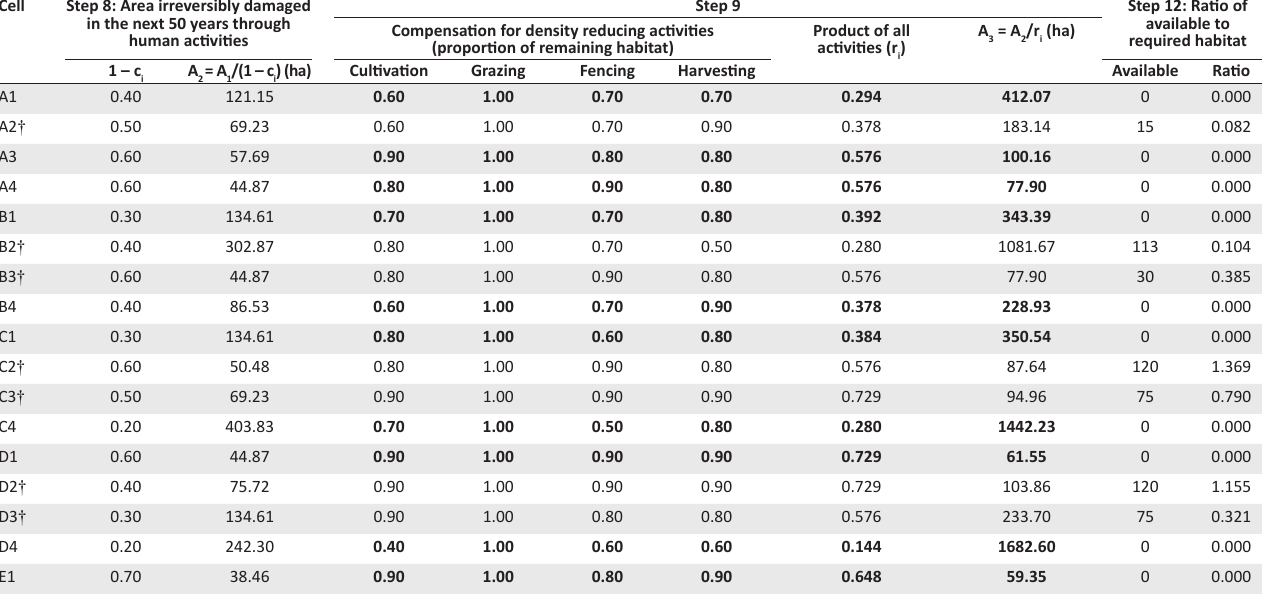
TABLE 2c: Brackenridgea zanguebarica minimum conservation area size using Burgman et al. ’s method (Steps 8, 9 and 12): Scenario 2 – No grazing. Cell Step 8: Area irreversibly damaged in the next 50 years through